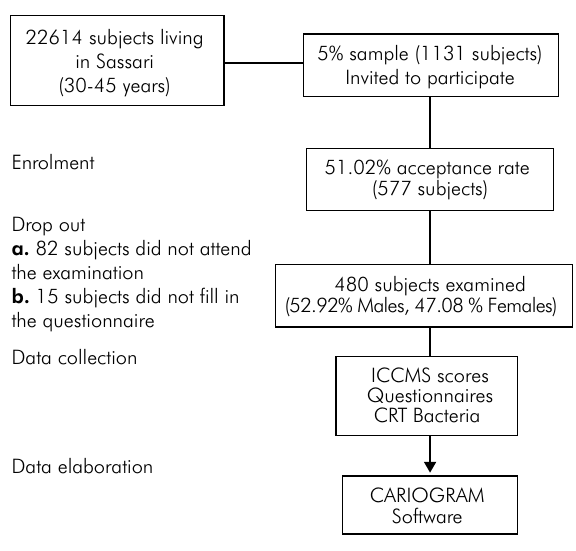
Figure 1. Flow chart of the